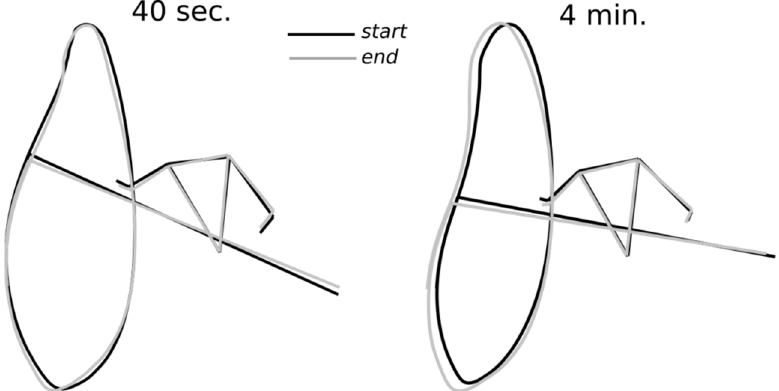
Figure 4. Mean start posture and paddle tip trajectory for the 15 first cycles (black) and 15 last cycles (grey) of the 40 s ( left ) and 4 min ( right ) condition, for a typical subject.